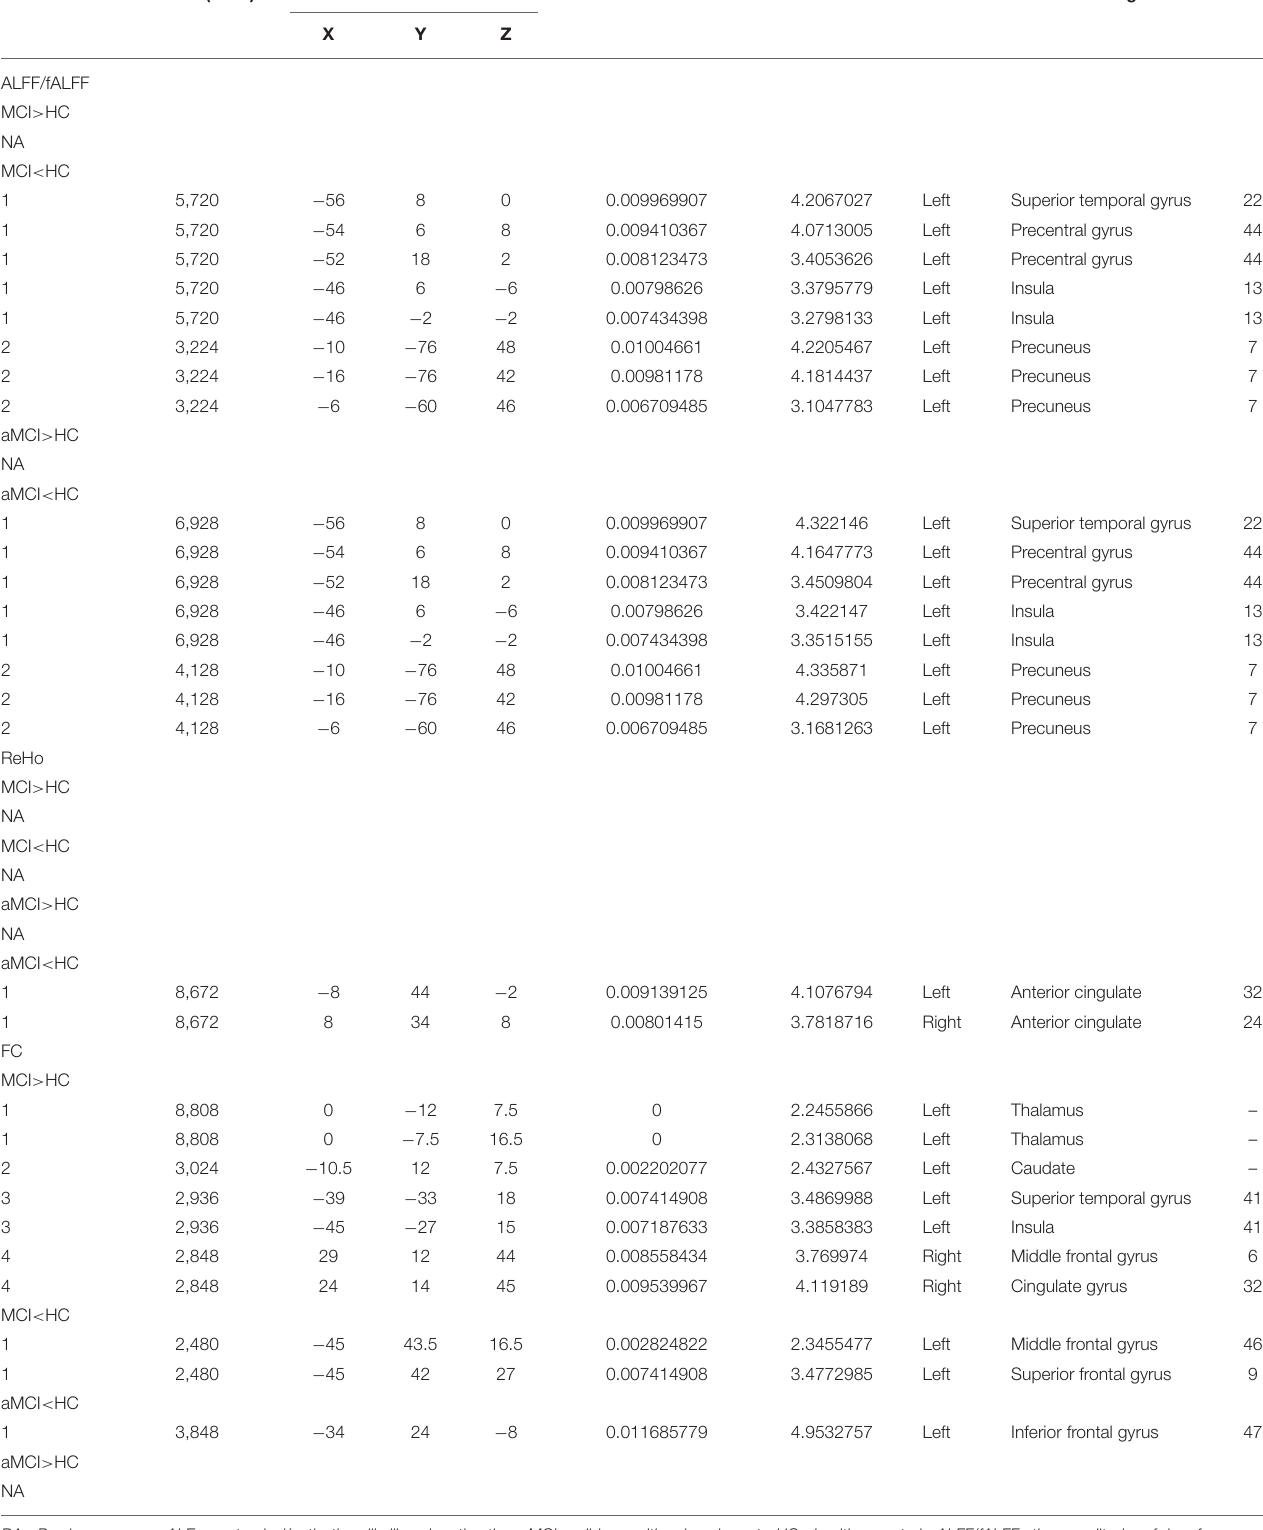
TABLE 2 | All clusters from the ALE analysis. Cluster Volume (mm 3 ) MNI Maximum ALE value Z value Side Anatomical regions